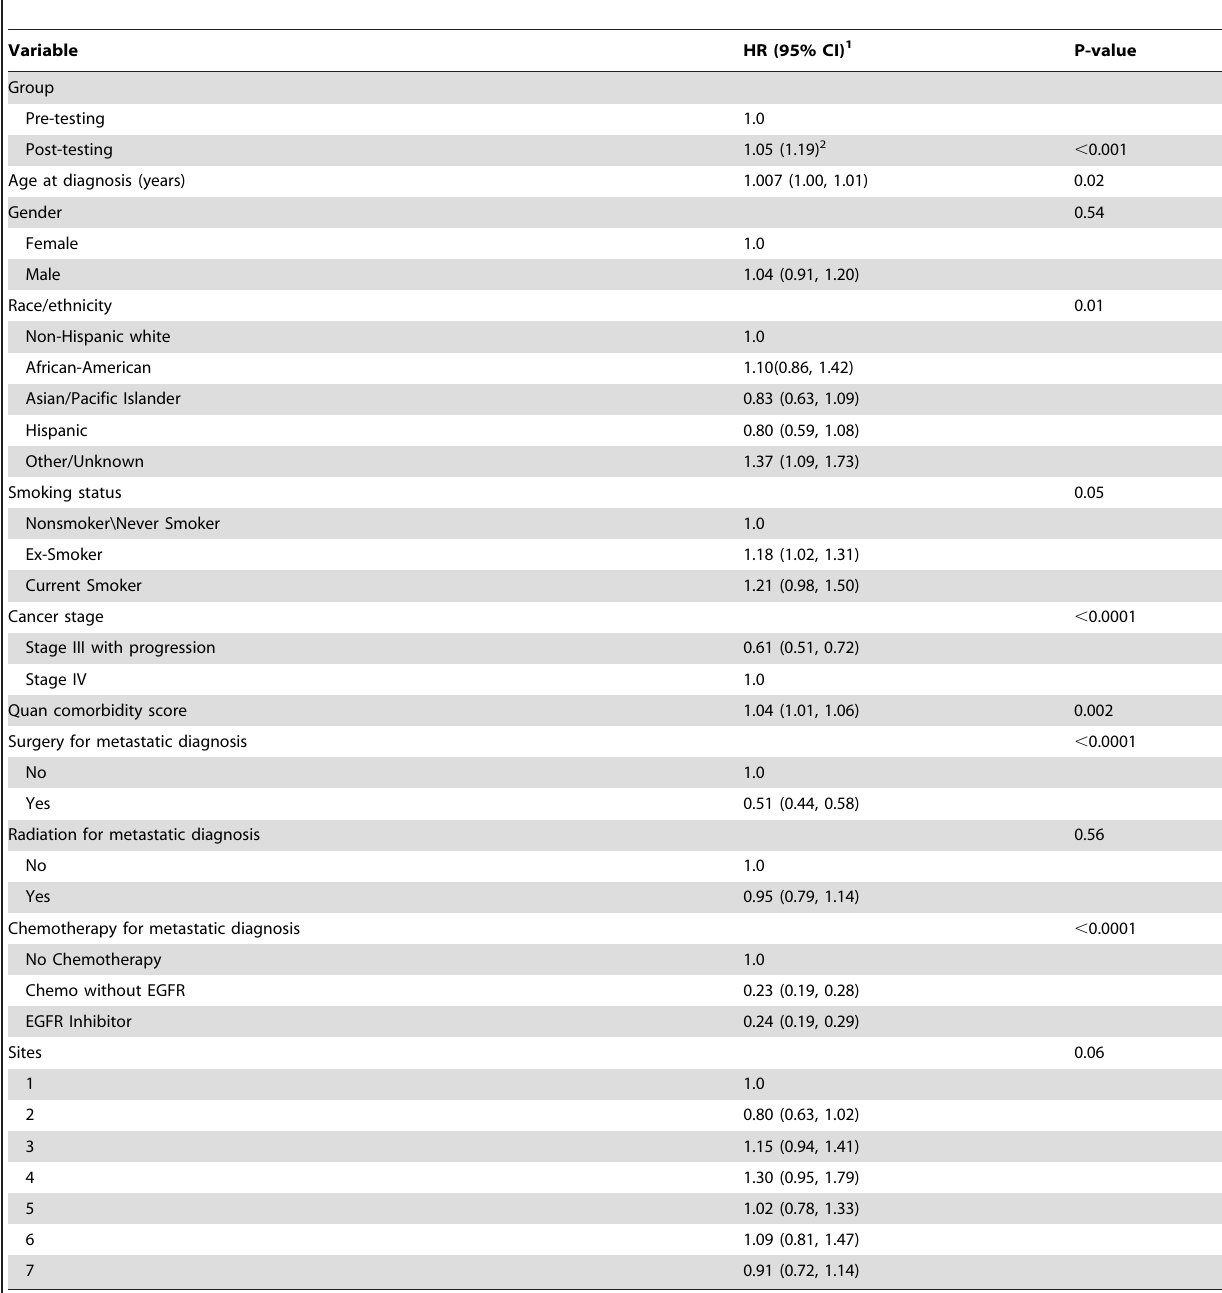
Table 4. Hazard ratios for overall survival by testing group and other characteristics, estimated from multivariable cox proportional hazards